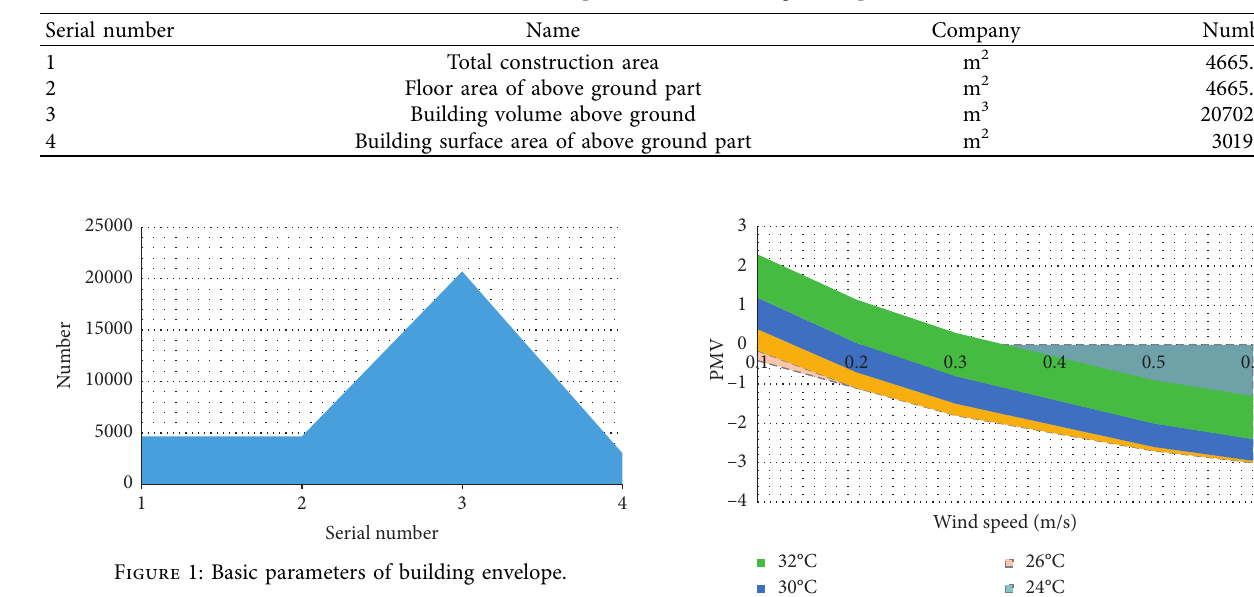
Table 2: Basic parameters of building envelope.